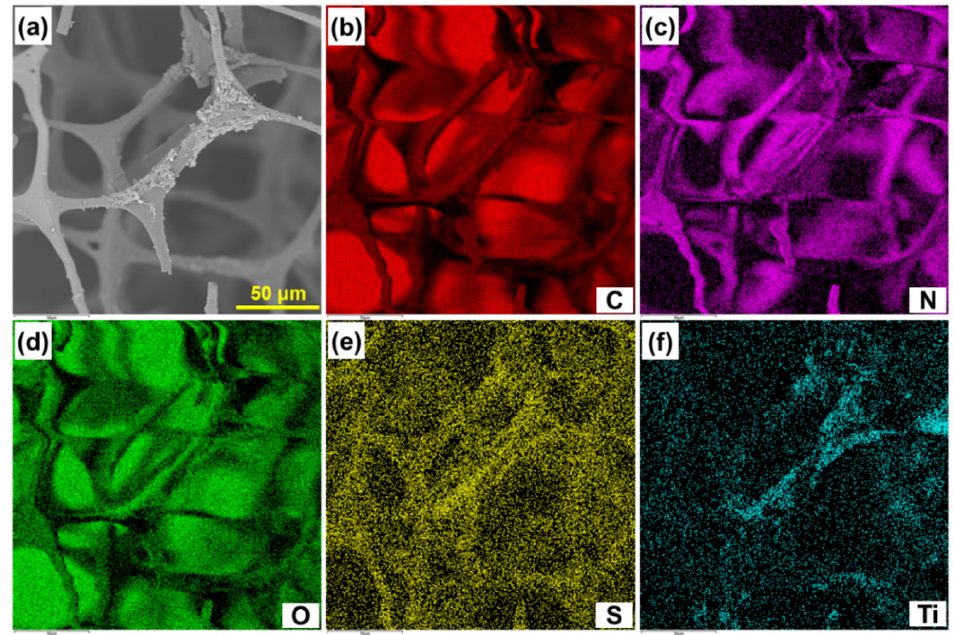
Figure 2. SEM image of MF/Ti 3 C 2 T x /PmPD ( a ); SEM-mapping images of C, N, O, S and Ti of MF/Ti 3 C 2 T x /PmPD, respectively ( b – f) .